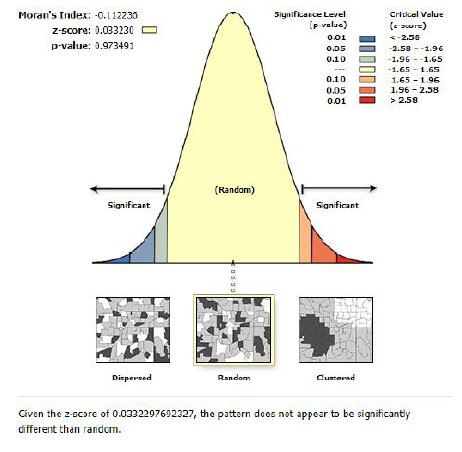
Figure 9: Spatial